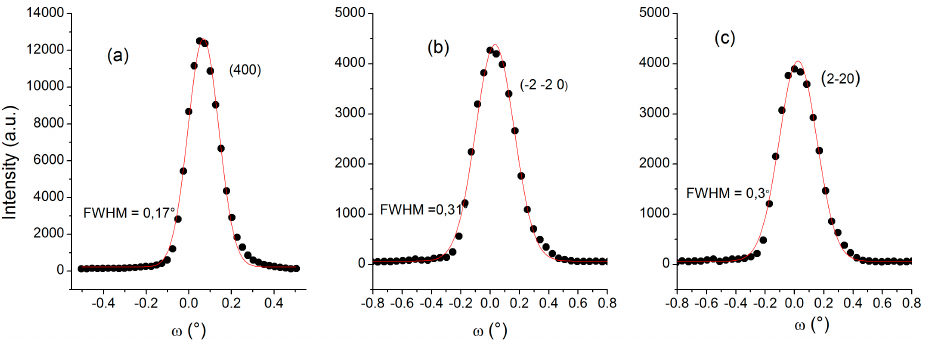
Figure 9. Neutron rocking curve of the Ca 2 Fe 2 O 5 (CFO) single crystal (400) ( a )- and (220) ( b and c )-type Bragg reflections, obtained by single crystal neutron diffraction on 5C2@LLB in Saclay ( λ = 0.83 Å).